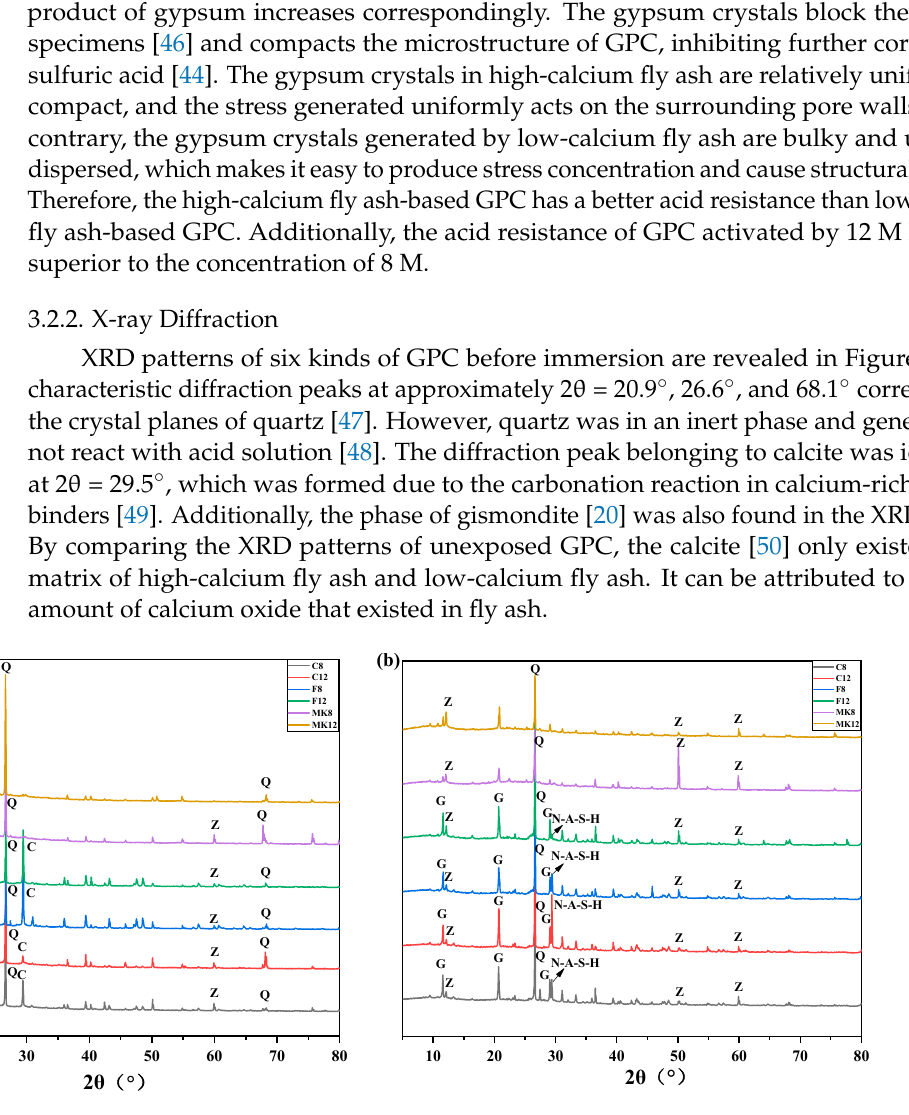
Figure 8. XRD patterns of GPC exposed to sulfuric acid solution for: ( a ) 0 day; ( b ) 98 days. Q = quartz, Z = gismondite, C = calcite, G = gypsum.